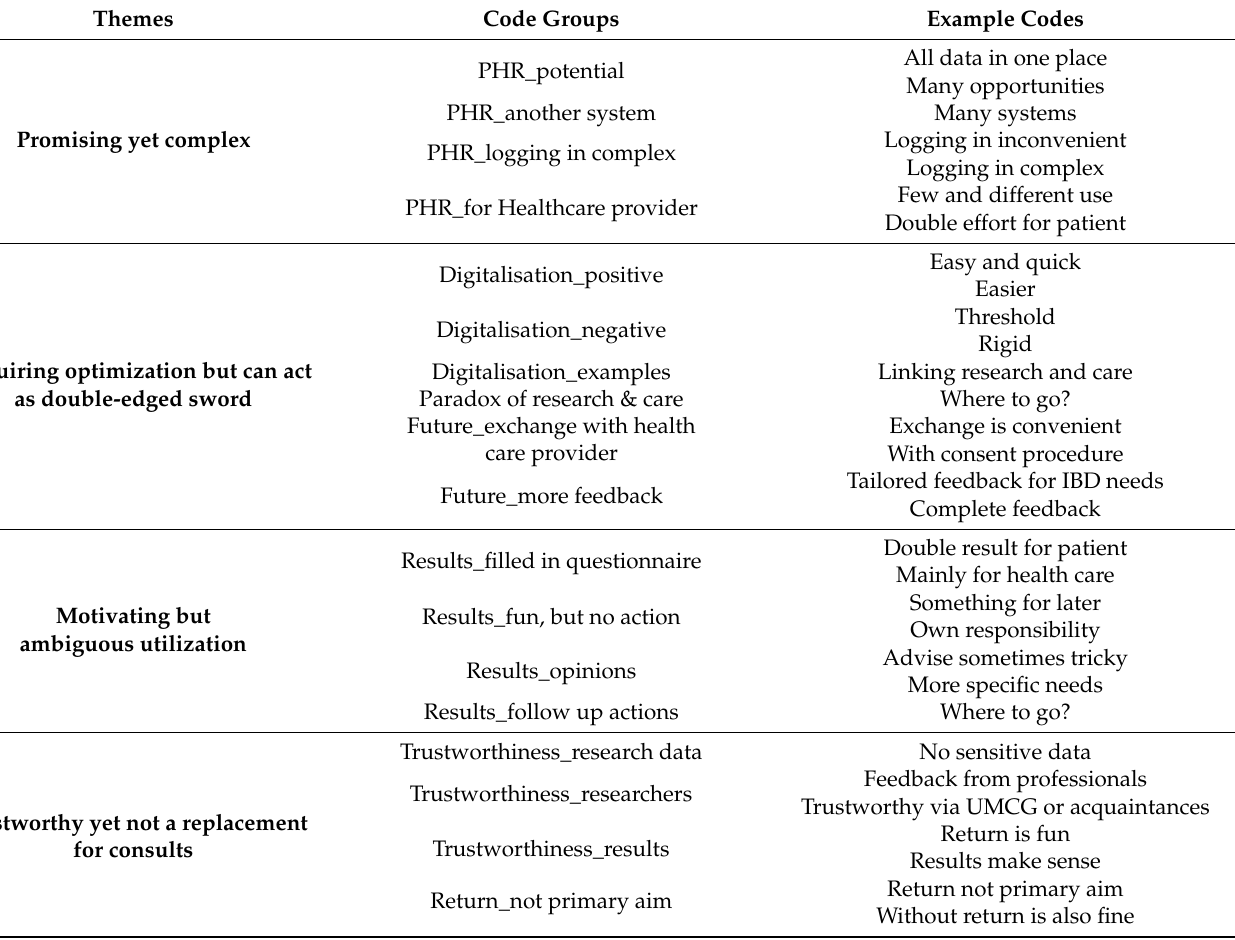
Table 2. Coding protocol